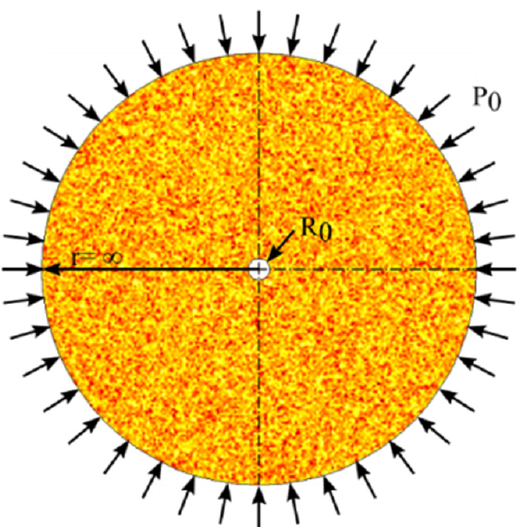
Figure 9. Mechanical model of circular stress field with a center borehole. Table 2. Mechanical parameters used for model validation.